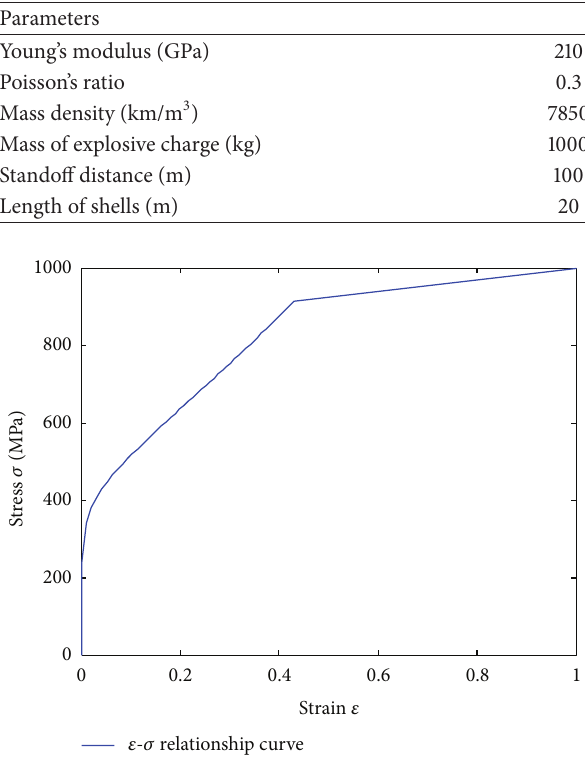
Table 1: Material properties and parameters of UNDEX.